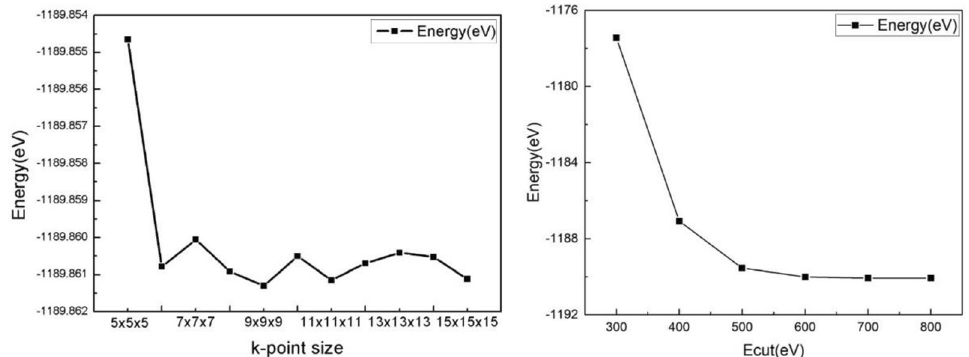
Figure 1. K point and cut-off energy test.